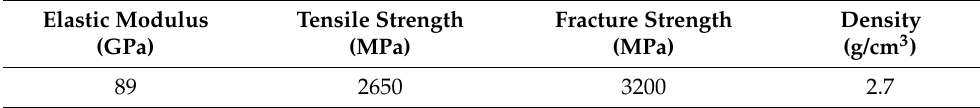
Table 3. Performance parameters s of basalt fibers.